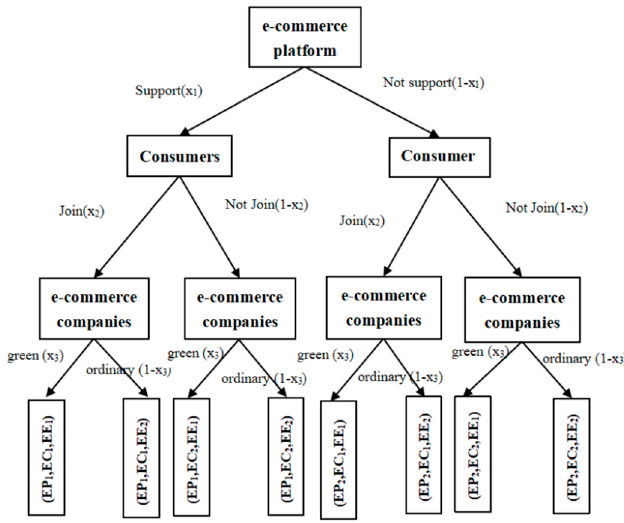
Figure 1. The evolutionary game structure tree of strategies.